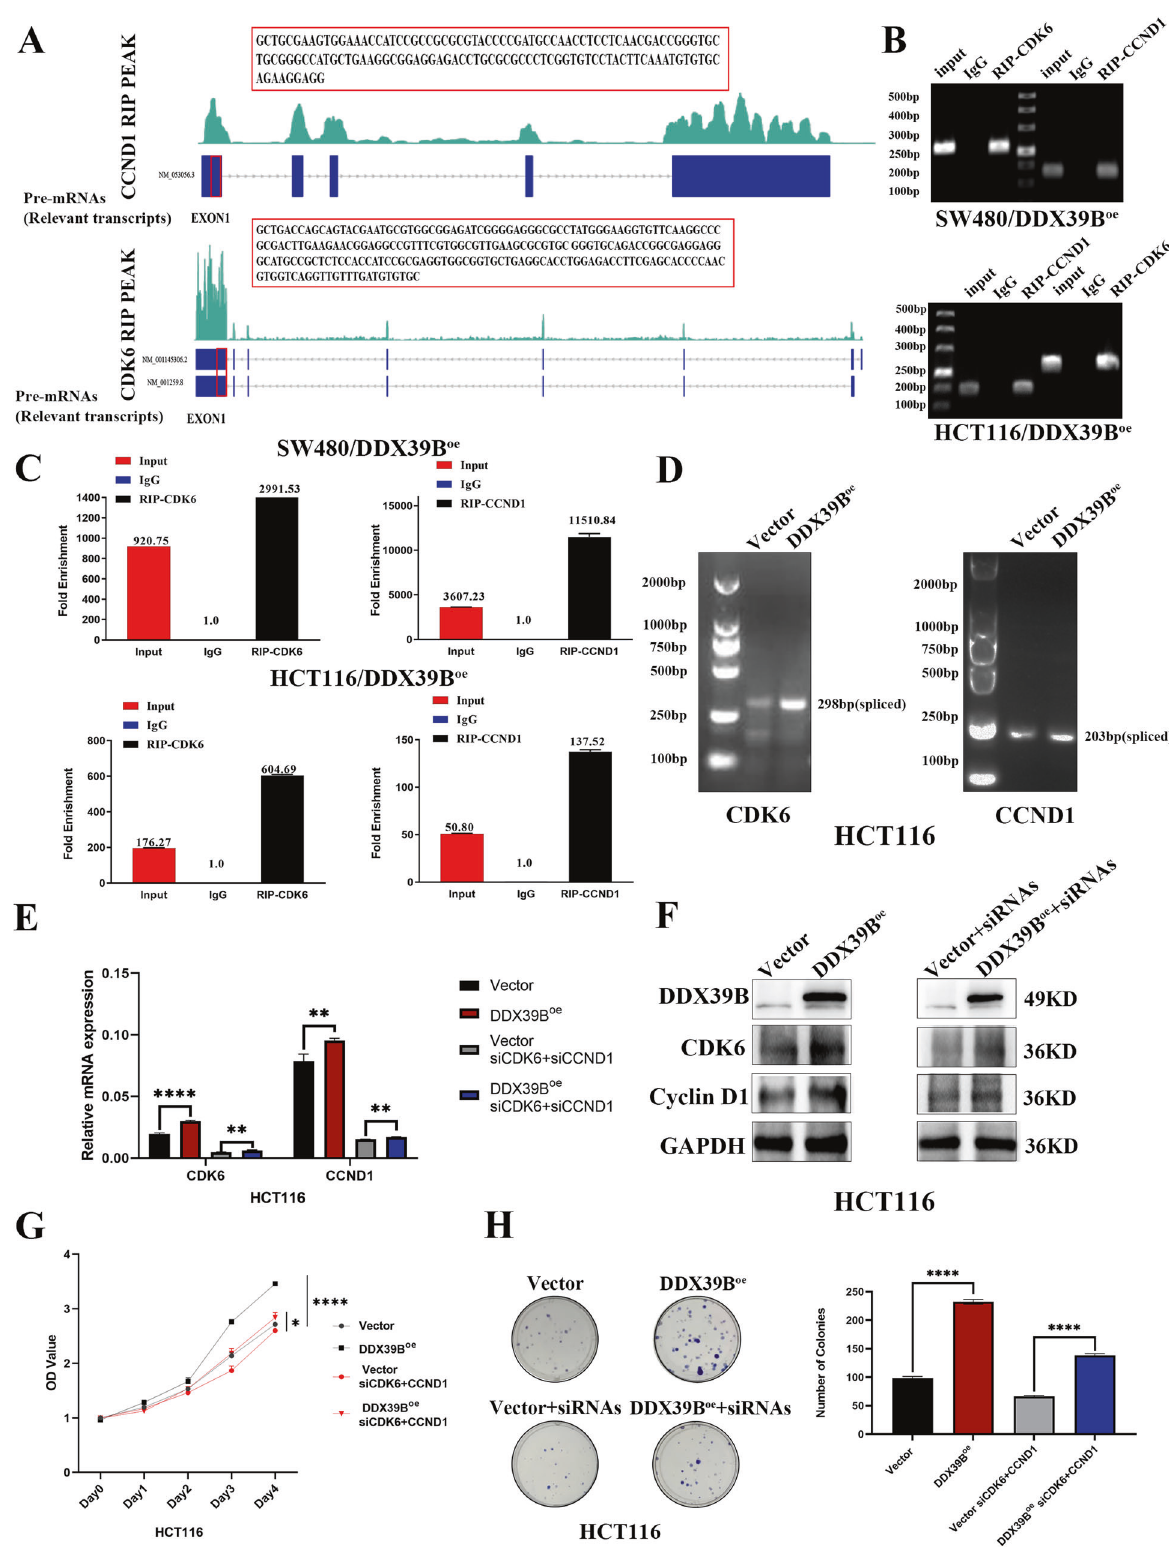
Cyclin/CDK complex are the driving force of the cell cycle. It is through various cyclins and cyclin-dependent protein kinases (CDK) that cells could orderly catalyze the phosphorylation and dephosphorylation of a series of target proteins, and then